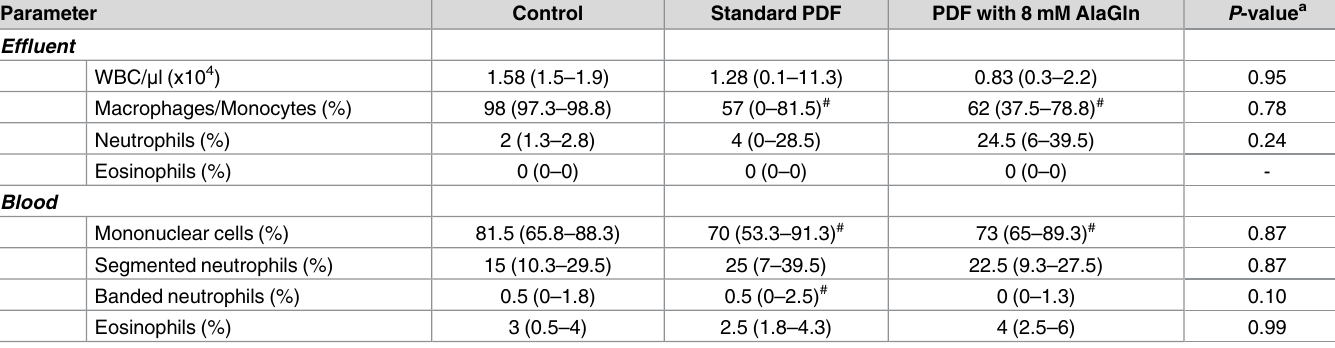
Table 5. Effluent and blood parameters of the mouse model of PD-related